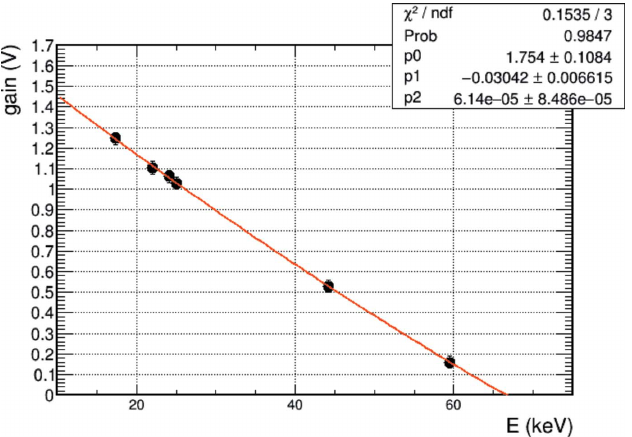
Figure 2 Gain versus energy calibration curves. The intercept with the horizontal axis indicates that the maximum threshold that can be set is at (cid:3) 67